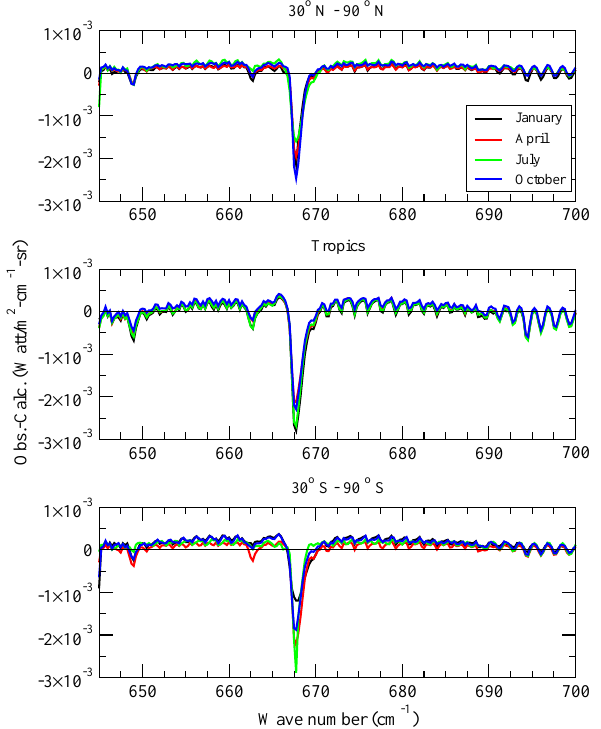
Fig. 1. IASI spectral residuals averaged over a period of two weeks during January, April, July, and, October 2008. The input state vec- tors are ECMWF short-range forecast fields. The residuals have been computed using the RTTOV model. Results are shown for (a) Northern Hemisphere, (b) Tropics, and, (c) Southern Hemisphere.